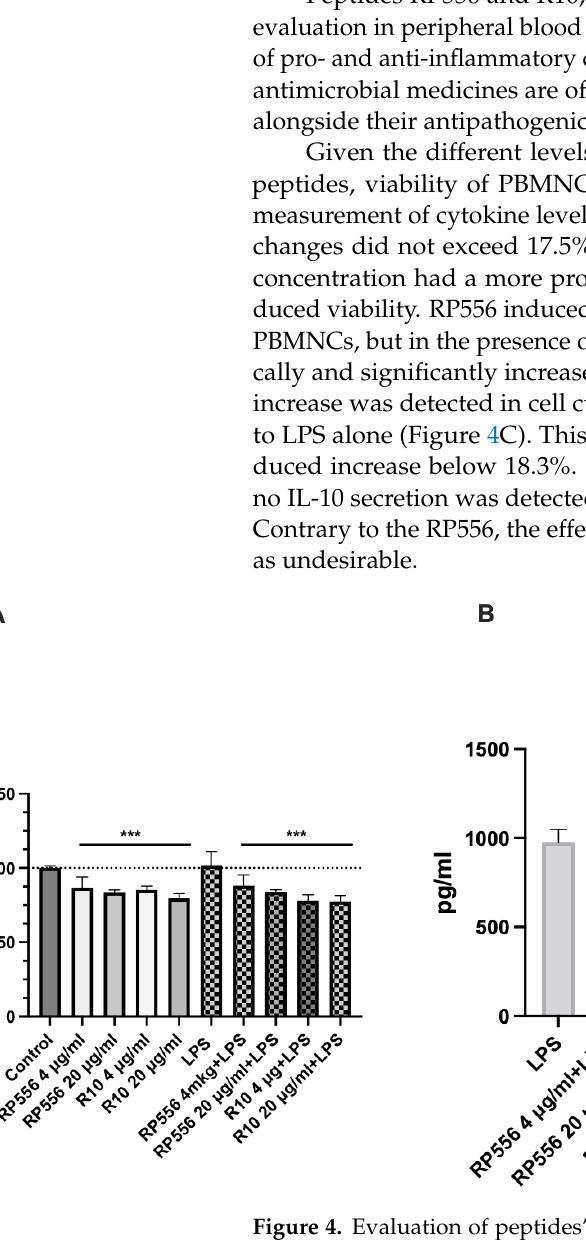
Figure 4. Evaluation of peptides’ effect on peripheral blood mononuclear cell (PBMNC) viability ( A ) and secretion of TNF- α ( B ) and IL-10 ( C ). LPS—lipopolysaccharide, control—cells incubated under normal conditions; n = 3, * p < 0.05, ** p < 0.01, *** p < 0.001.